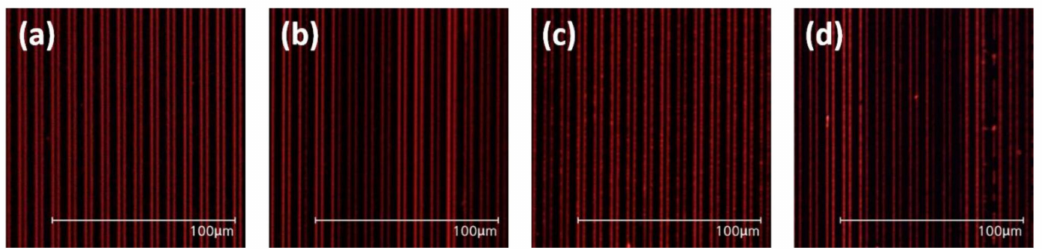
Figure 5. UV exposed OM images of inkjet-printed onto the microchannel of the donor substrate after drying ( a ) at room temperature, ( b ) 30 ◦ C, ( c ) 50 ◦ C, and ( d ) 80 ◦ C in a vacuum chamber.